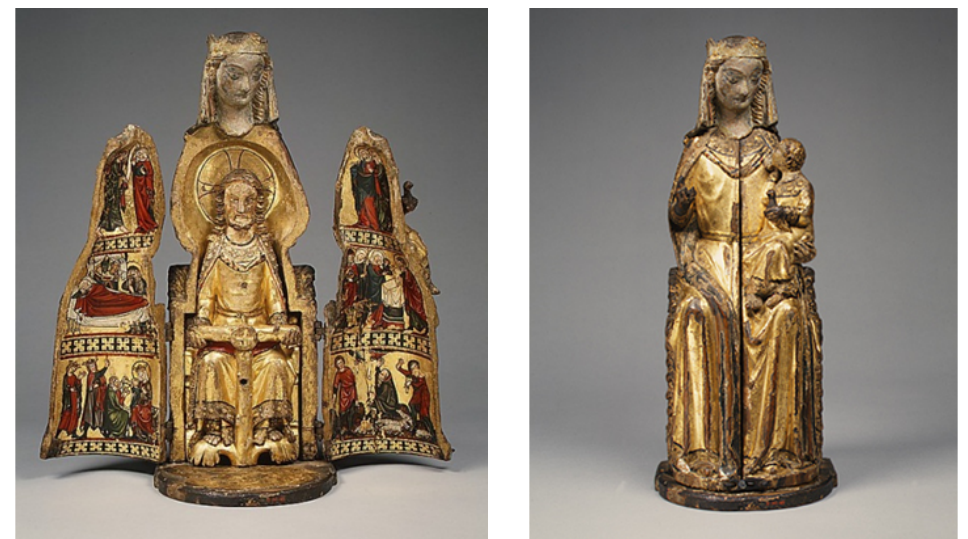
Figure 3 Shrine of the Virgin , Germany, Rhine Valley, c. 1300. Oak, linen covering, paint, gilding, gesso. Open: 14 1/2 x 13 5/8 in. (36.8 x 34.6 cm), Closed: 14 1/2 x 5 in. (36.8 x 12.7 cm.) Metropolitan Museum of Art, New York